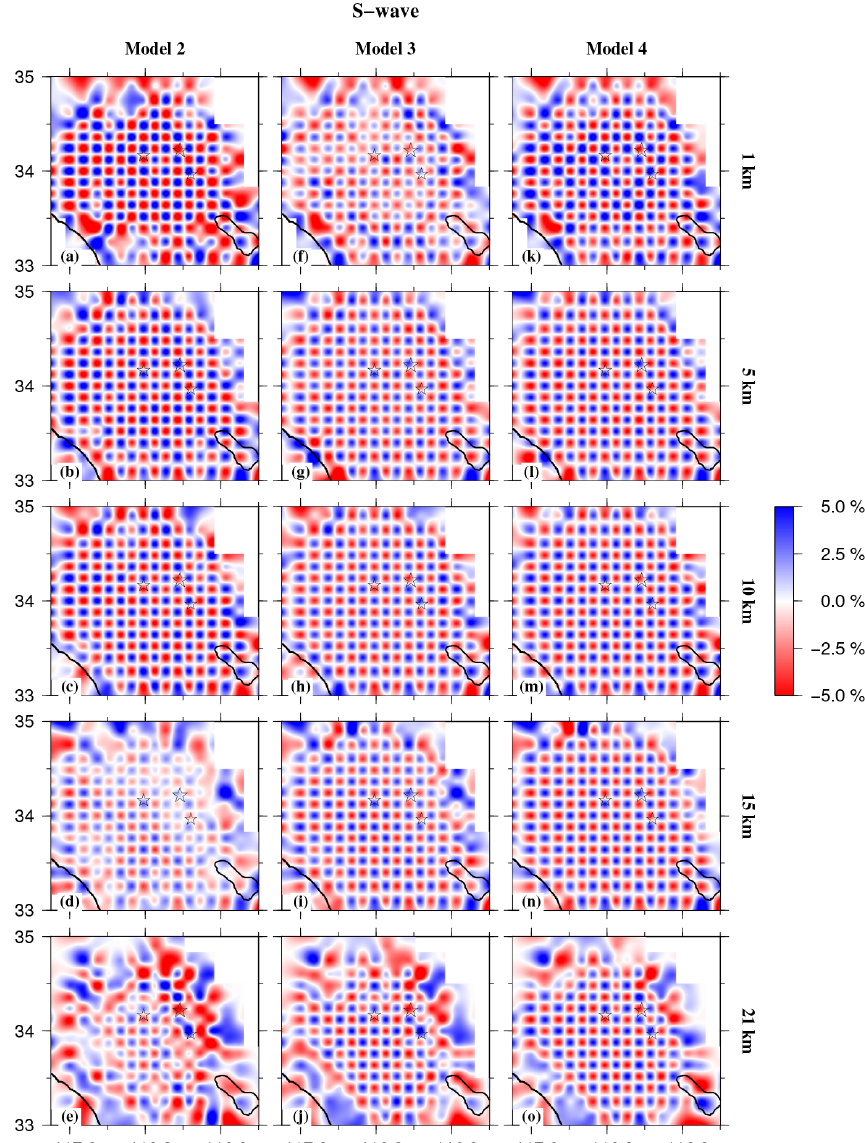
Figure 9. The same as Fig. 8 but for S wave velocity